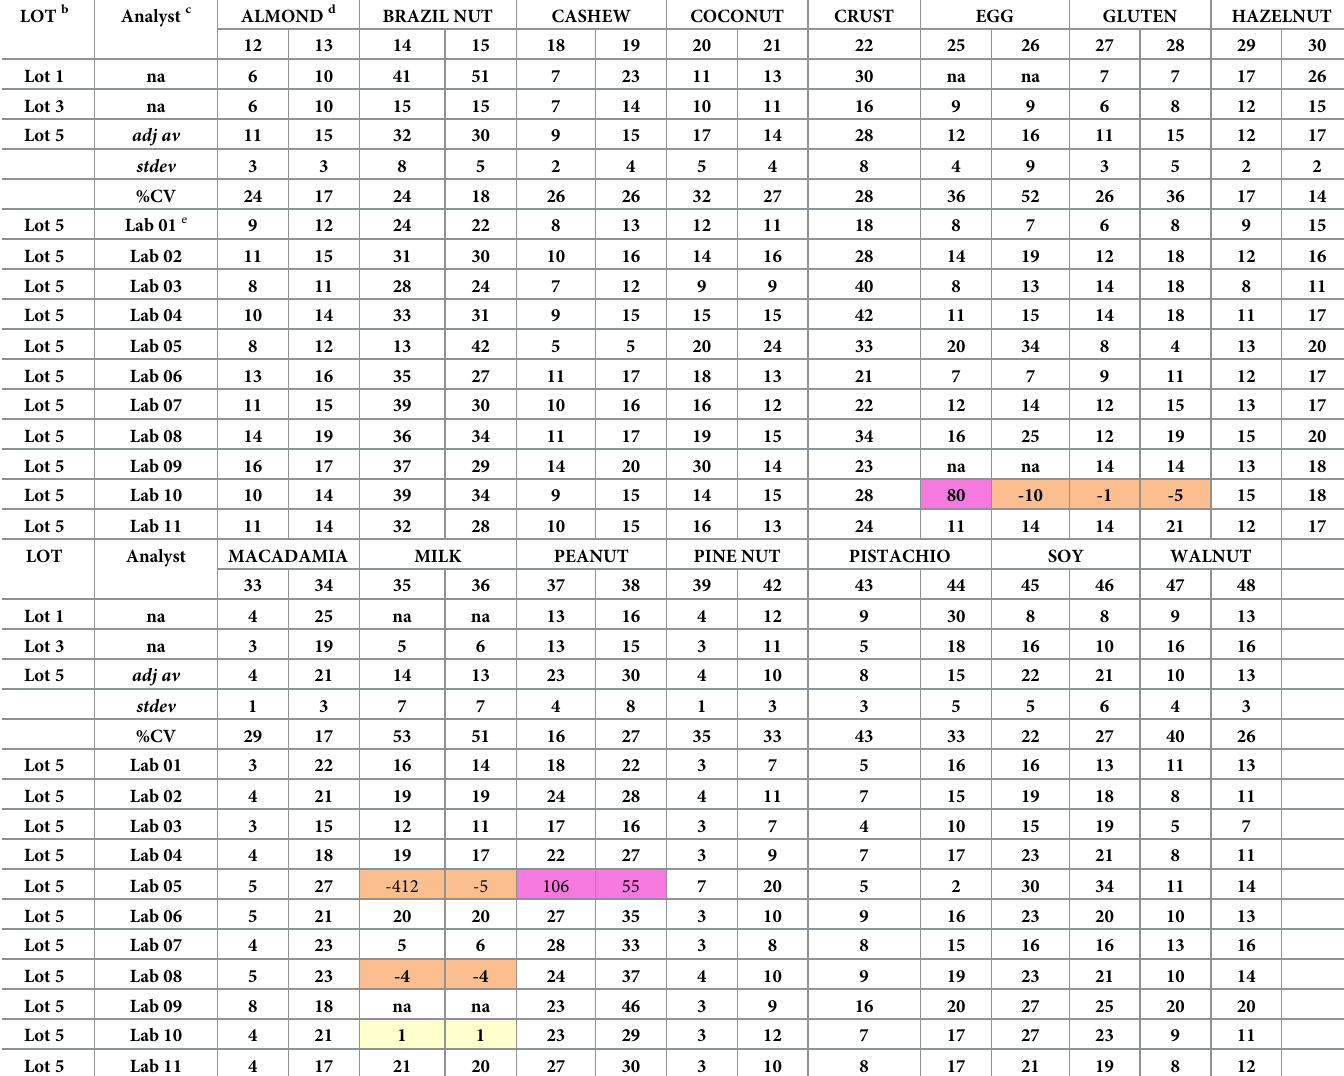
Table 8. Comparison signal / noise, above background, spanning the calibration standards [(S/N-1) S7 / (S/N-1) S1 ] a . LOT